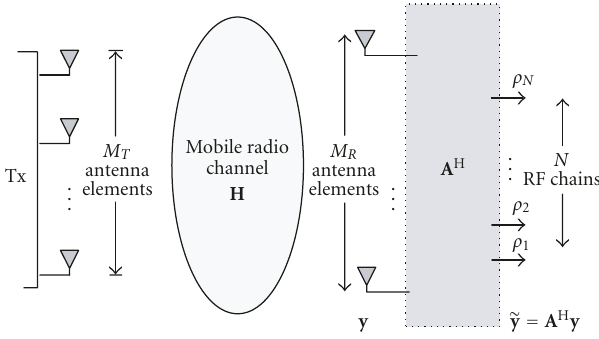
Figure 1: System model of receive antenna subarray